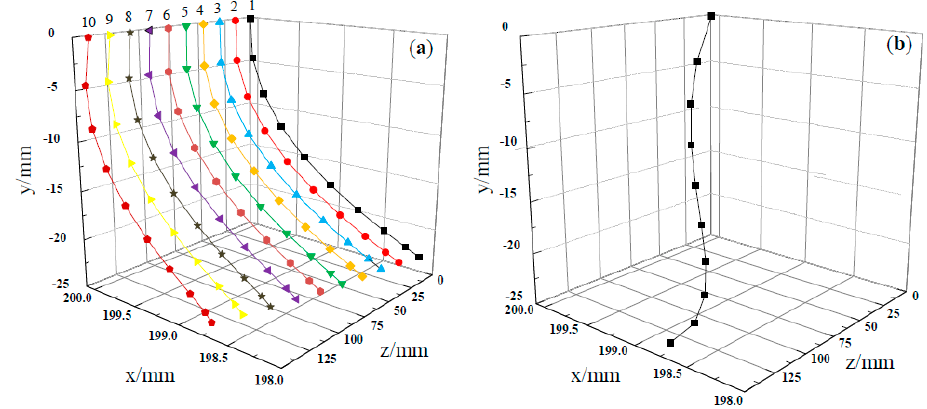
Figure 3. Loading displacements of different clamps in UC-SF and C-SF. ( a ) UC-SF; ( b ) C-SF.